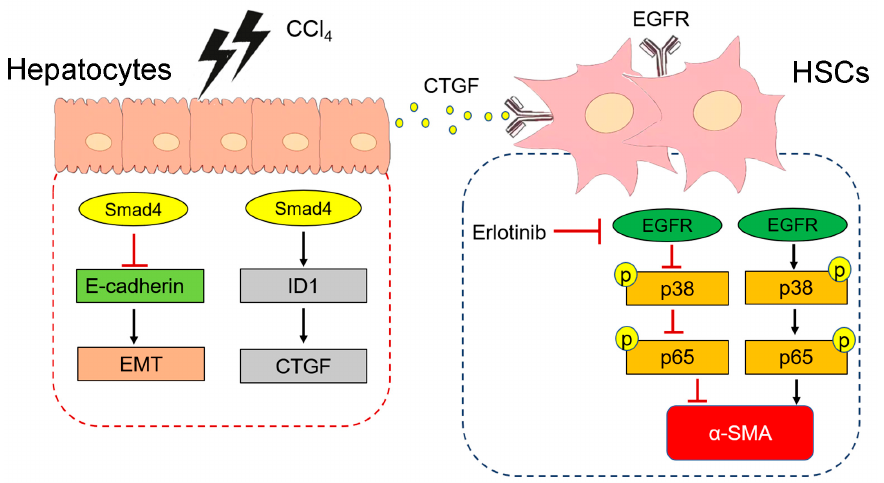
Figure 7. Schematic diagram of the mechanism via which hepatocyte-specific Smad4 deficiency al- leviates liver fibrosis. In liver fibrosis, the expression of Smad4 in hepatocytes was upregulated, leading to increased ID1 and CTGF expression in hepatocyte; thereafter, secreted CTGF upregulated the phosphorylation of p38 and p65 via the EGFR receptor to promote HSC activation and liver